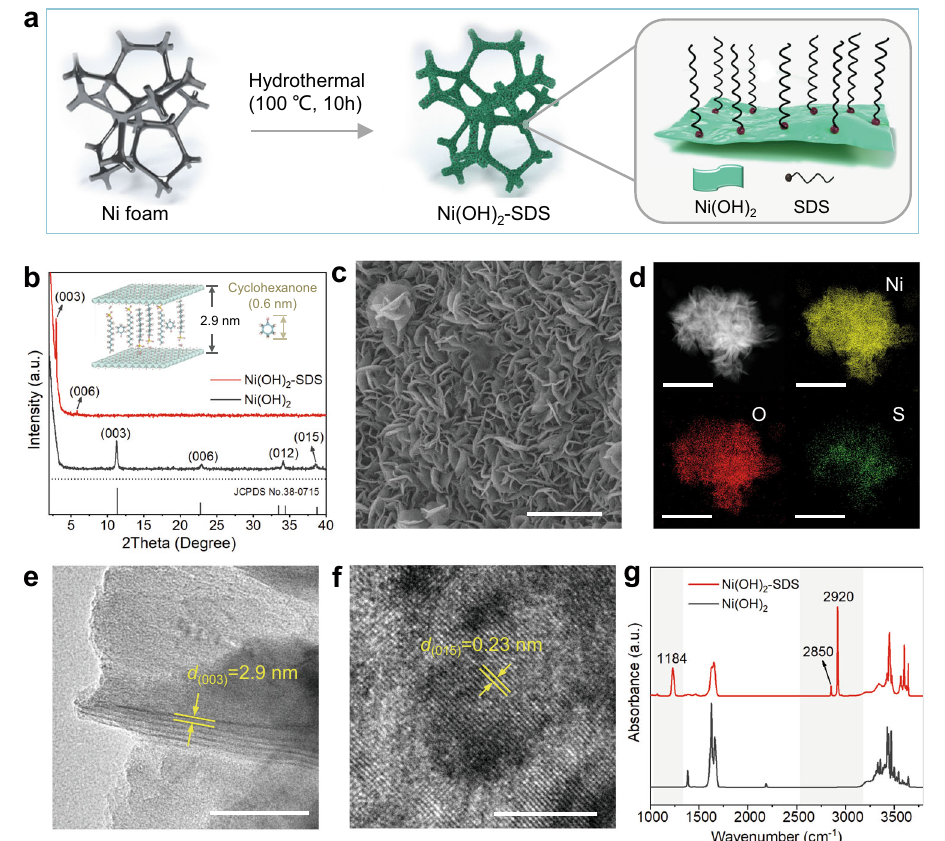
Fig. 2 | Structural characterization of the Ni(OH) 2 -SDS catalyst. a Schematic illustration of the synthesis of Ni(OH) 2 -SDS on Ni foam. b , XRD patterns of the Ni(OH) 2 -SDS and pure Ni(OH) 2 samples. c SEM image of Ni(OH) 2 -SDS. Scale bar, 2 μ m. d HAADF-STEM image of Ni(OH) 2 -SDS and corresponding element maps